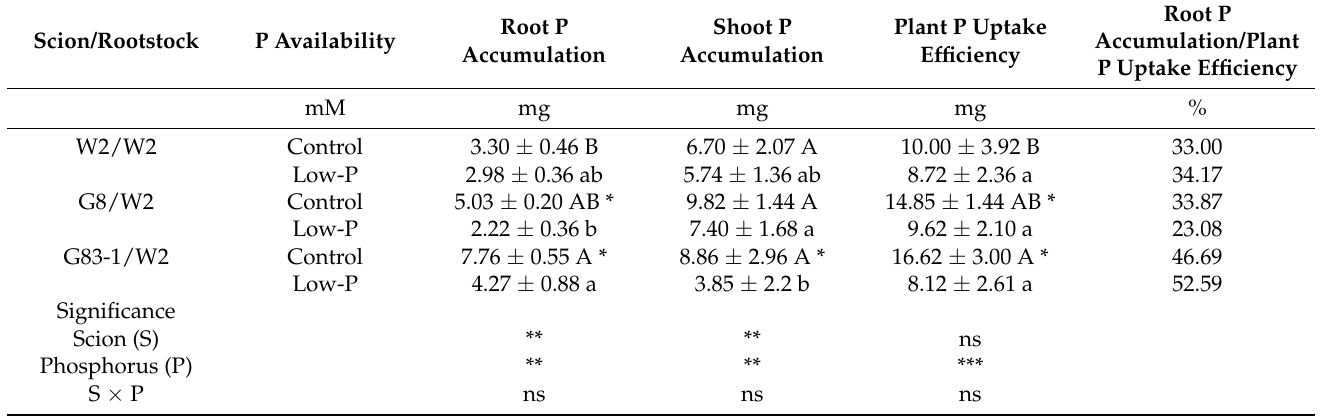
Table 2. Effects of scion cultivars, P availability and their interaction on P accumulation and P uptake efficiency.